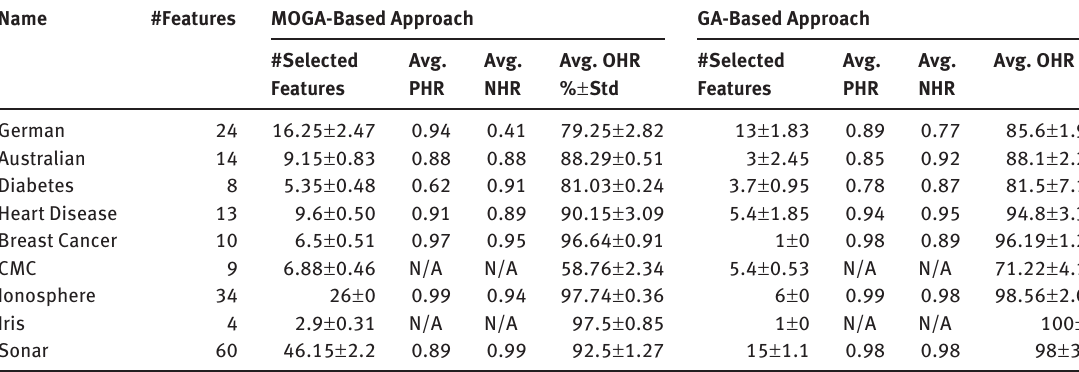
Table 6. Comparison of the Proposed Approach with the GA-Based Approach.